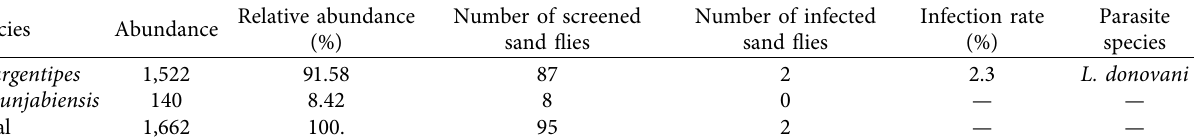
Table 1: Relative abundance and infection rate of sand flies.